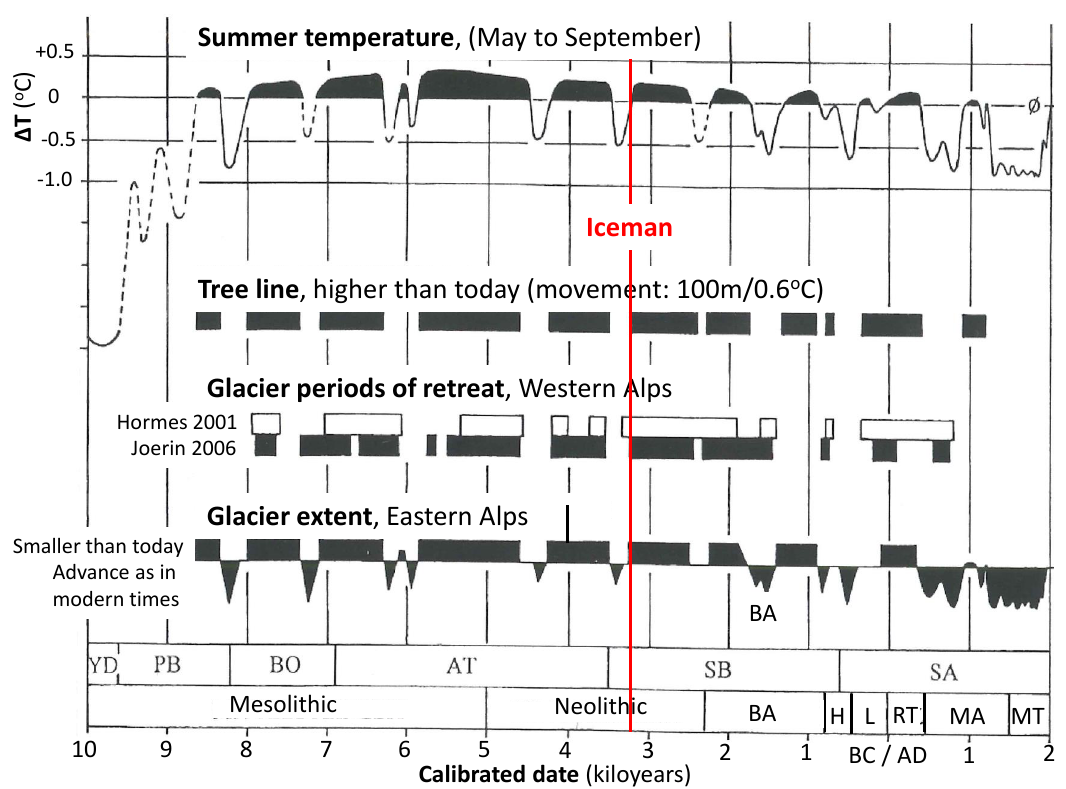
Figure 7. Schematic presentation of glacier and tree-line movements in the European Alps during the Holocene [22]. The periods of smaller glaciers and higher tree lines are indicated with the box symbols. Glacial advances are indicated with filled triangles and curves. The largest advances took place during the Little Ice Age (~AD 1300 to 1850). The top curve depicts the relative summer temperature variations deduced mainly from tree-line movements. The mean temperature between AD 1900 and 2000 is used as reference (ΔT = 0 o C). The red vertical line marks the time where the Iceman Ötzi died